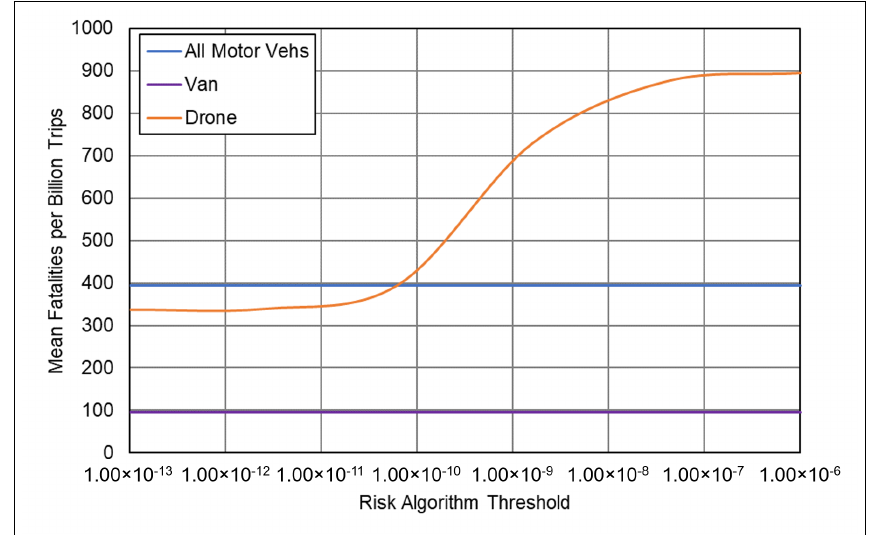
Figure 7. Mean Fatality Rates for the Case Study